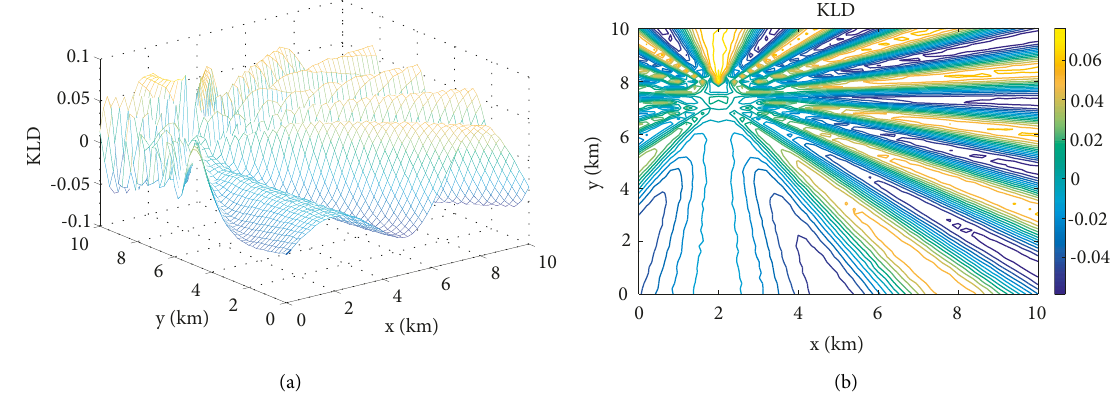
Figure 12: The simulation results when a target appears at Position B . (a) The 3D KLD information distance distribution. (b) The 2D KLD information distance distribution.